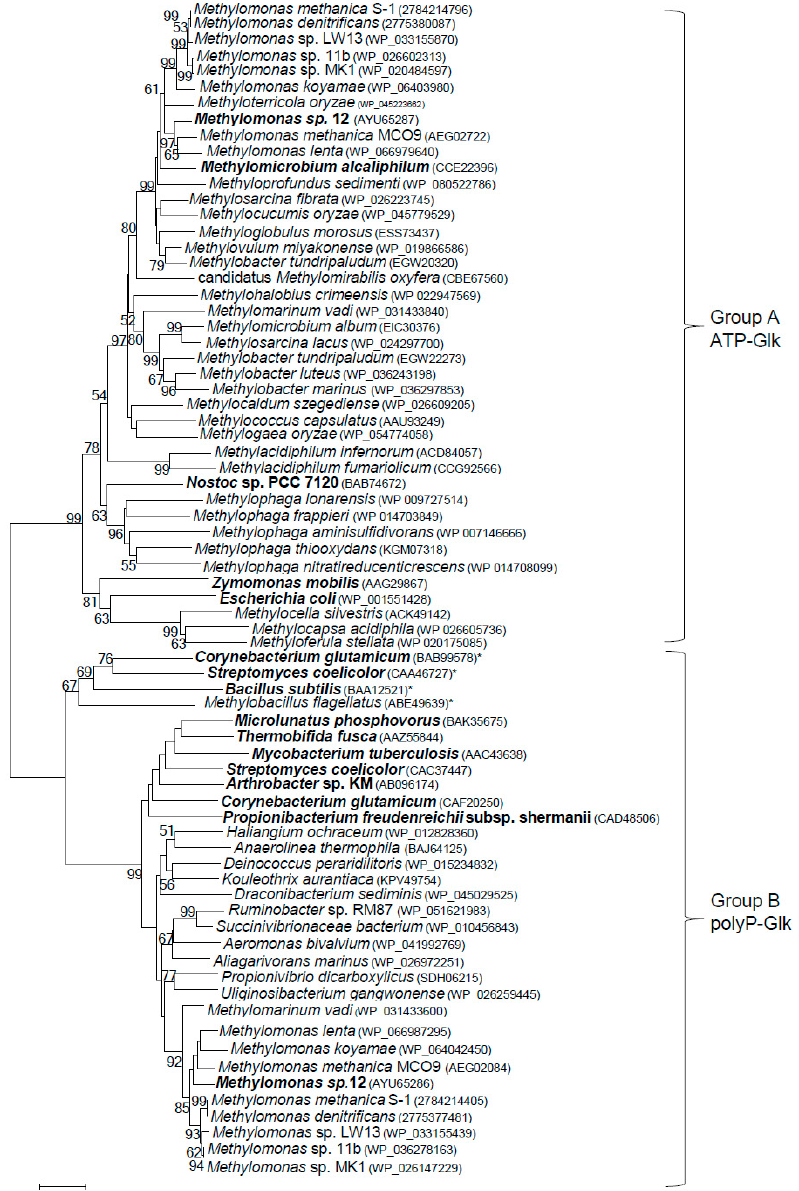
Figure 4. Phylogenetic tree constructed from the amino acid sequences of various putative and characterized bacterial ATP- and polyP-dependent glucokinases. The characterized enzymes are in bold and the amino acid accession numbers are in brackets. ATP-dependent glucokinases in the Group B are marked by asterisks. The scale bar corresponds to the number of substitutions per